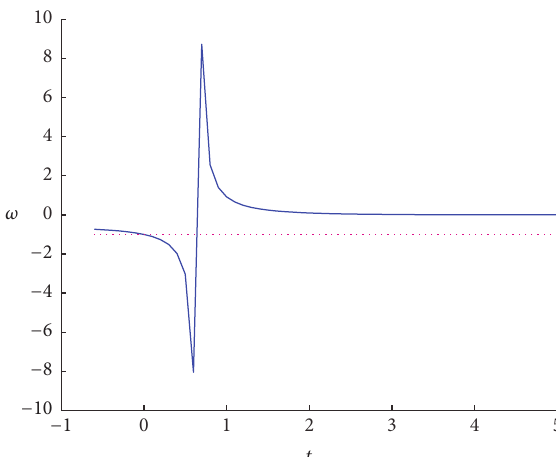
Figure 1: Evolution of 𝜔 with potential (24) as a function of time. For the numerical analysis we assume 𝑁 = 3 , 𝑐 = 6 , and 𝛽 = 1 . From